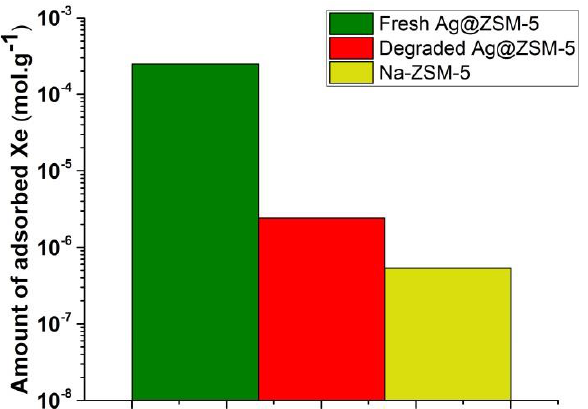
Figure 1. Xenon adsorption capacity at 5 ppm (298 K) for the fresh ( green ) and degraded ( red ) Ag@ZSM-5 and for Na-ZSM-5 ( yellow ). Y-scale in Log.